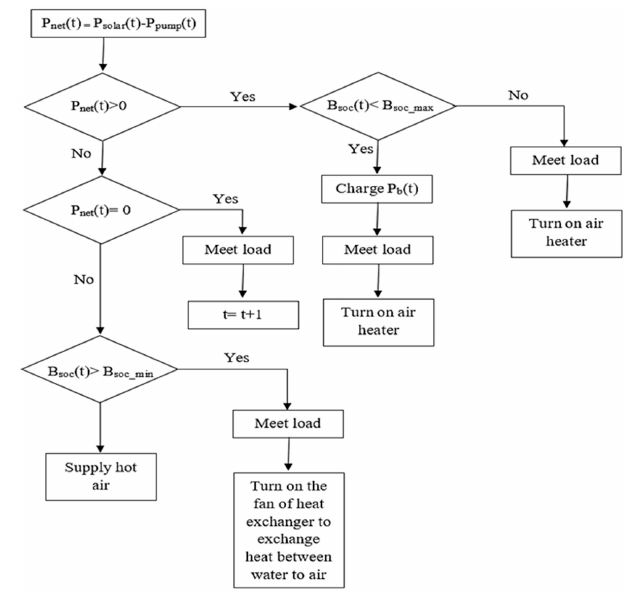
Figure 3. Algorithm for optimisation of energy.